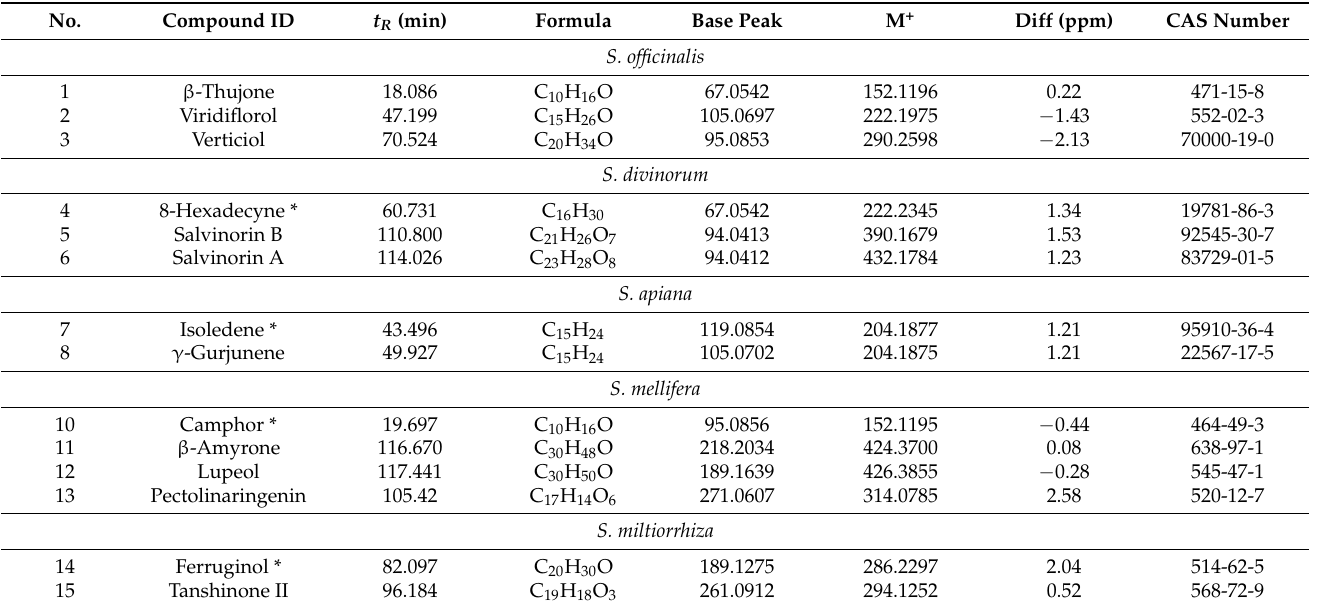
Table 4. Proposed marker compounds tentatively identified for the differentiation of selected Salvia